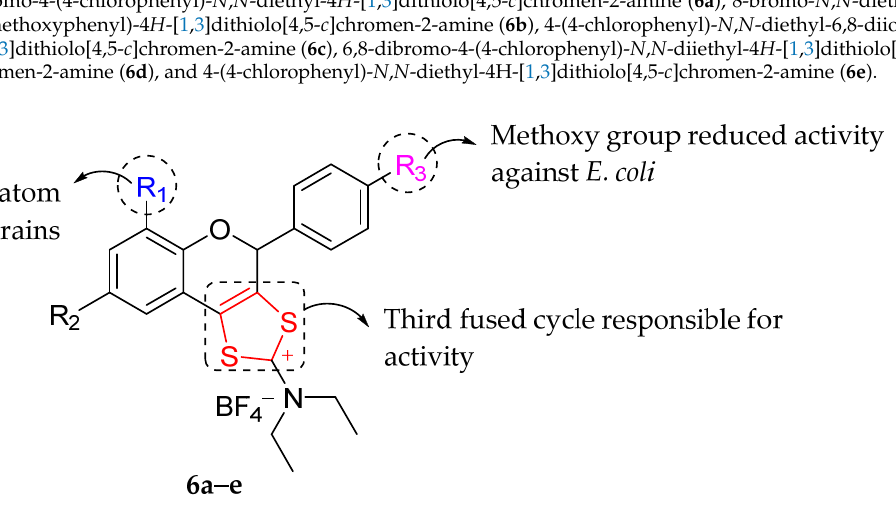
Figure 22. Summary of SAR of sulfur-containing tricyclic flavonoids against S. aureus and E. coli [88].